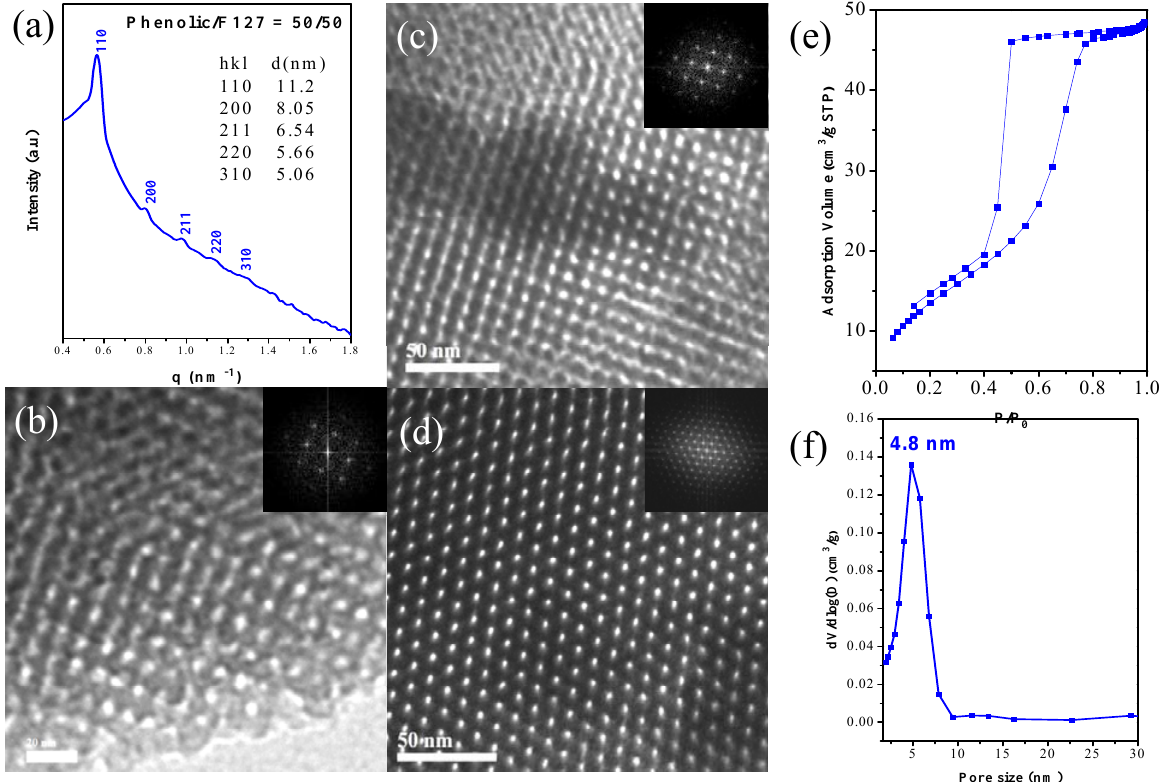
Figure 7. ( a ) SAXS pattern; ( b – d ) TEM images viewed from ( b ) (110); ( c ) (100) and ( d ) (111) (insets: corresponding Fast Fourier transform); ( e ) N ( f ) pore size distribution curve of the bcc mesoporous phenolic templated by F127 at a phenolic resin content of 50 wt